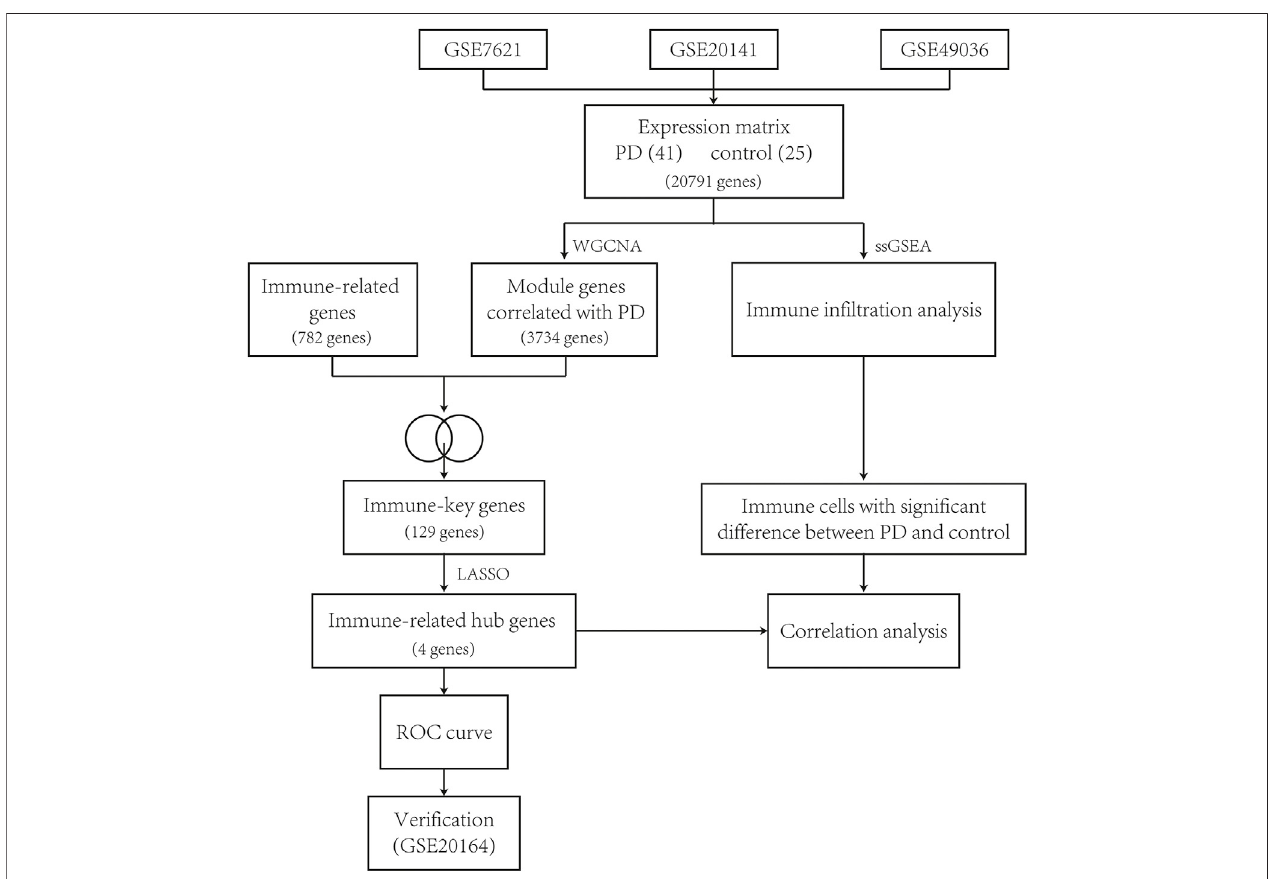
FIGURE 1 | Flowchart of this